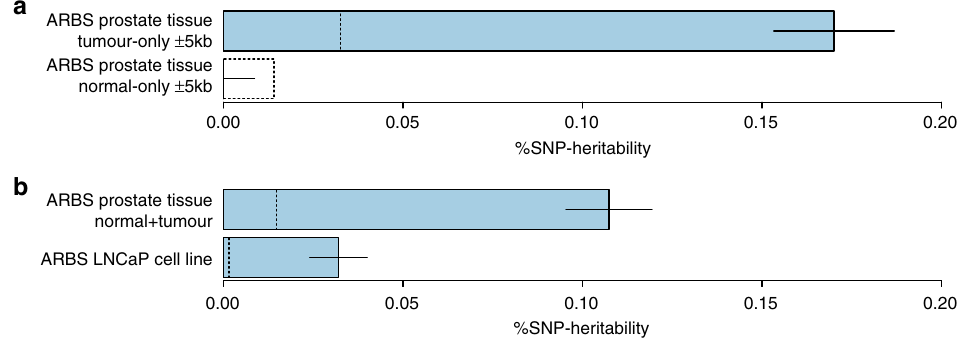
Figure 1 | Functional partitioning for variants within ARBS for PrCa. Bars graphs detailing %SNP heritability estimates from two models of PrCa relevant functional annotations. ( a ) Joint comparison of variants within 5kb of tumour-only and normal-only regions in the ARBS in prostate tissue ( P ¼ 2.1 (cid:2) 10 (cid:3) 19 for difference by Z -test). ( b ) Estimates from ARBS in prostate tissue (no longer using a 5kb flank) and ARBS in LNCaP cell lines 7 ( P ¼ 4.4 (cid:2) 10 (cid:3) 7 for % SNPs Þ is labelled by the dashed lines. Error bars show analytical standard error of estimate. difference). The null ð %h 2 g ¼ NATURE COMMUNICATIONS|7:10979|DOI: